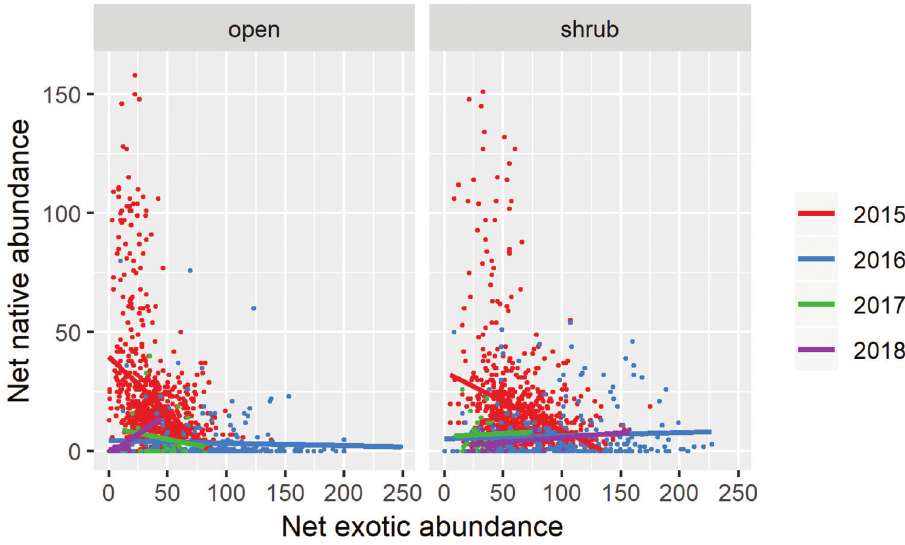
Figure 2. Net abundance of native annuals plotted against net abundance of exotic annuals for each year of the study (2015–2018). Statistics are shown in Suppl. material 1: Table